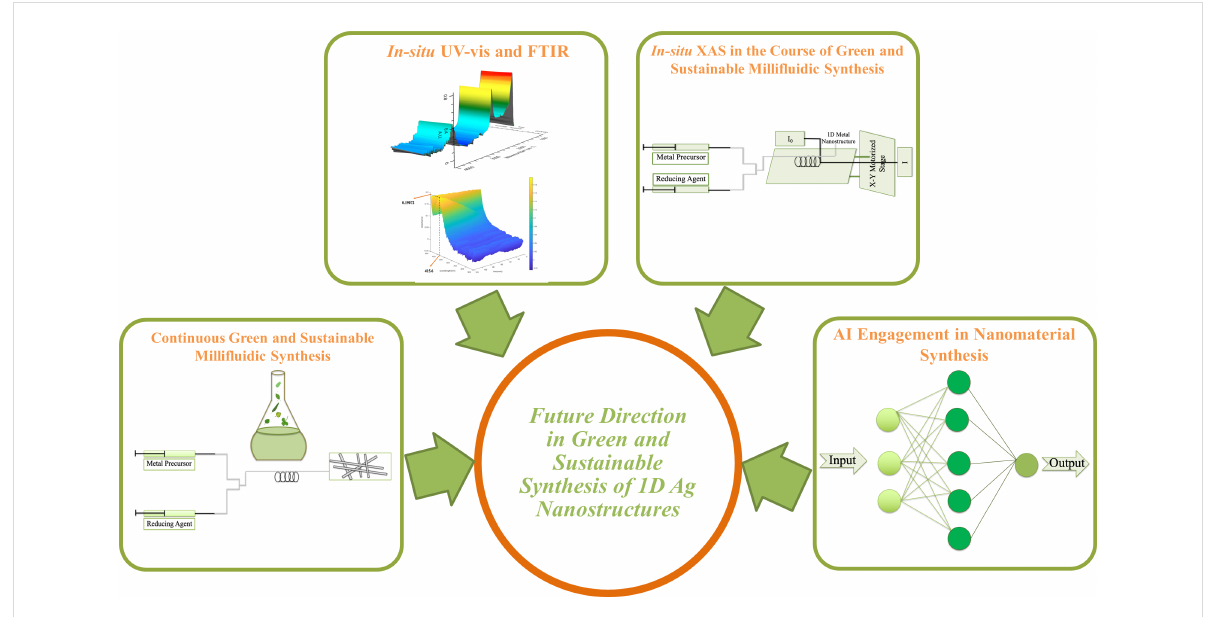
Figure 3: Expected future direction in green and sustainable synthesis of 1D Ag nanostructures.